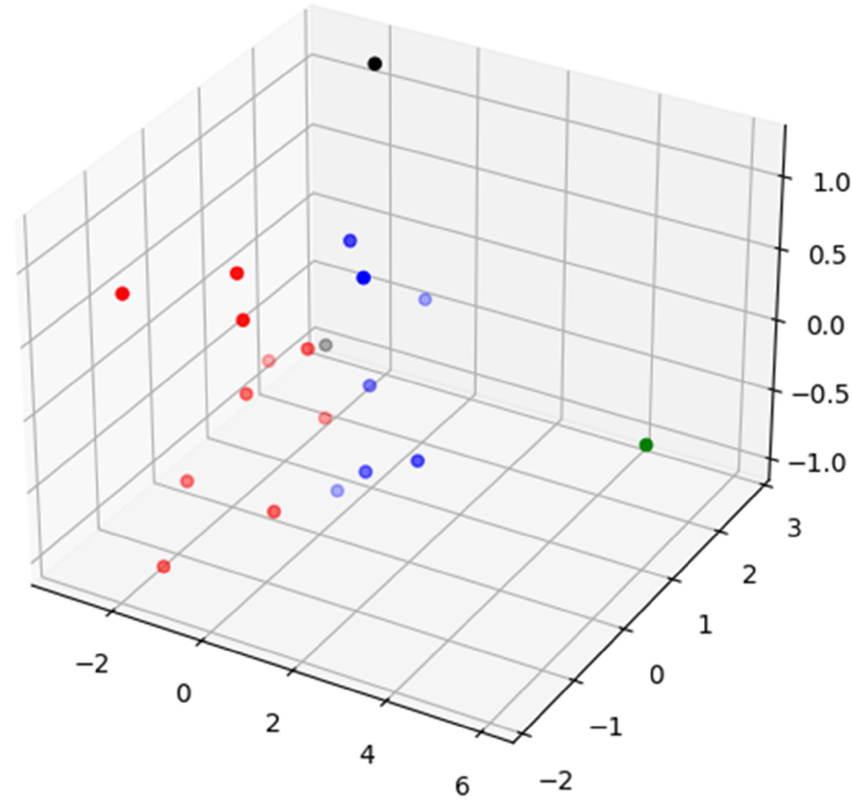
Figure 3. Visualization of the clusters of survey subjects after performing K-means (K = 4).